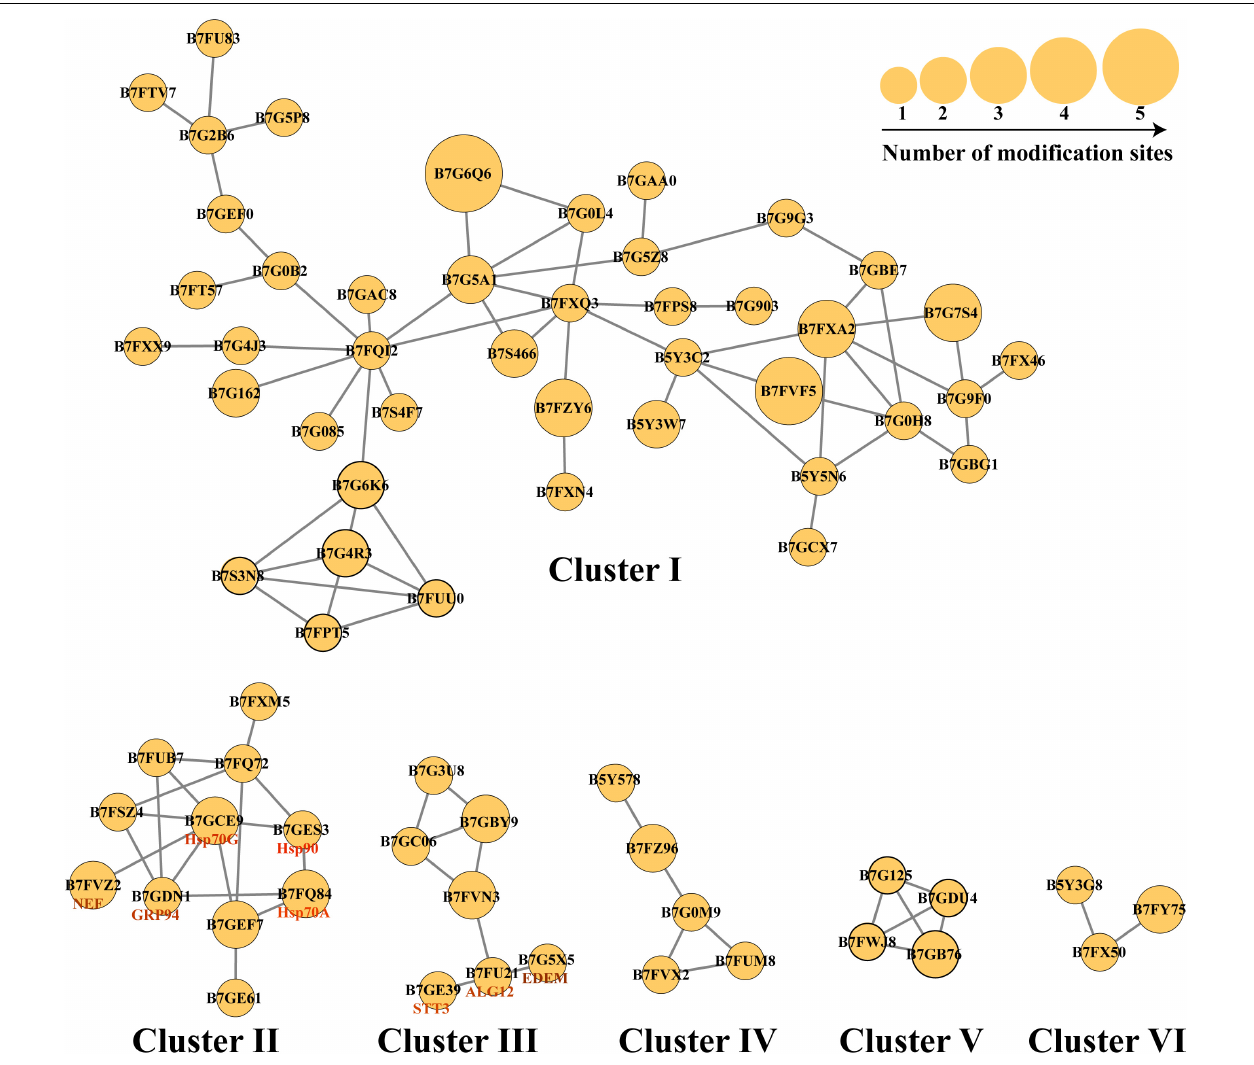
FIGURE 6 | The protein–protein interaction (PPI) networks. The PPI networks were divided into six interactional clusters, from cluster I to cluster VI. Each node is a N-glycoproteins. In total, 74 N-glycoproteins were identified from six clusters. B7FXM5 is mitochondrial chaperonin. B7FUB7 is endoplasmic reticulum (ER) luminal binding protein (BiP). B7FQ72 is mitochondrial chaperonin, Cpn60/Hsp60p. B7FSZ4 is a predicted protein. B7GEF7 is Heat shock protein Hsp90. B7GE61 is Heat shock protein Hsp70. B7G3U8 is a predicted protein. B7GBY9 is glycosylphosphatidylinositol (GPI)-anchor transamidase. B7GC06 is GPI transamidase complex, GPI16/PIG-T component, involved in GPI anchor biosynthesis. B7FVN3 is mannosyltransferase. The number represents the number of modified sites.